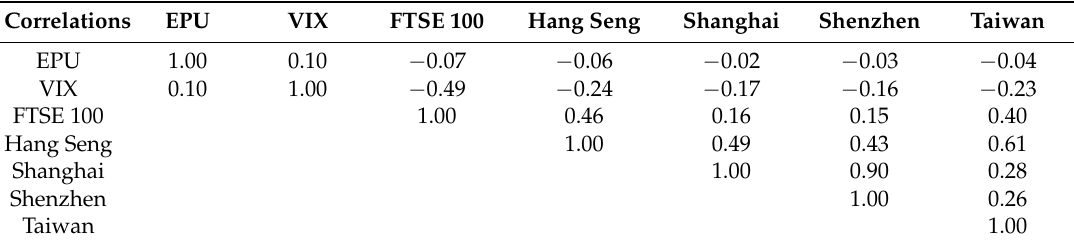
Table 2. Correlation